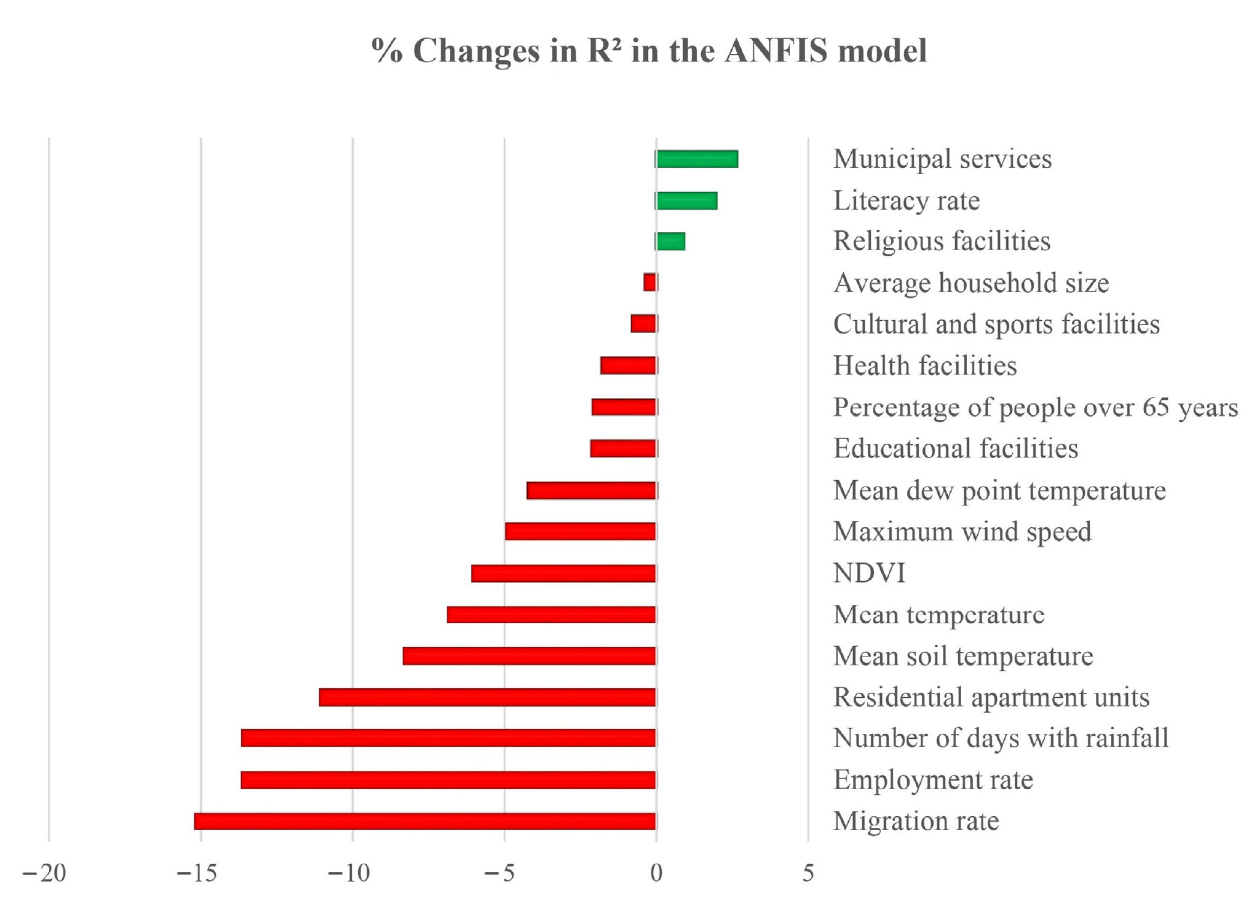
Figure 3. The contribution of input variables in predicting the spatial distribution of COVID-19 prevalence using the ANFIS model.